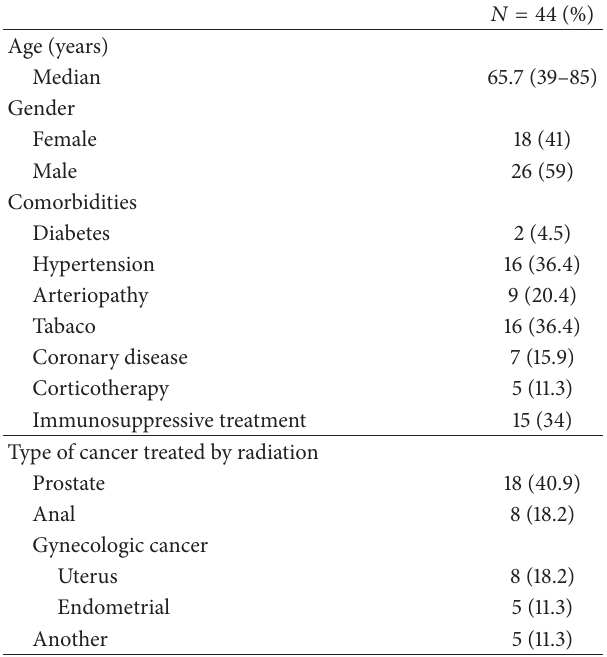
Table 1: Demographical data of